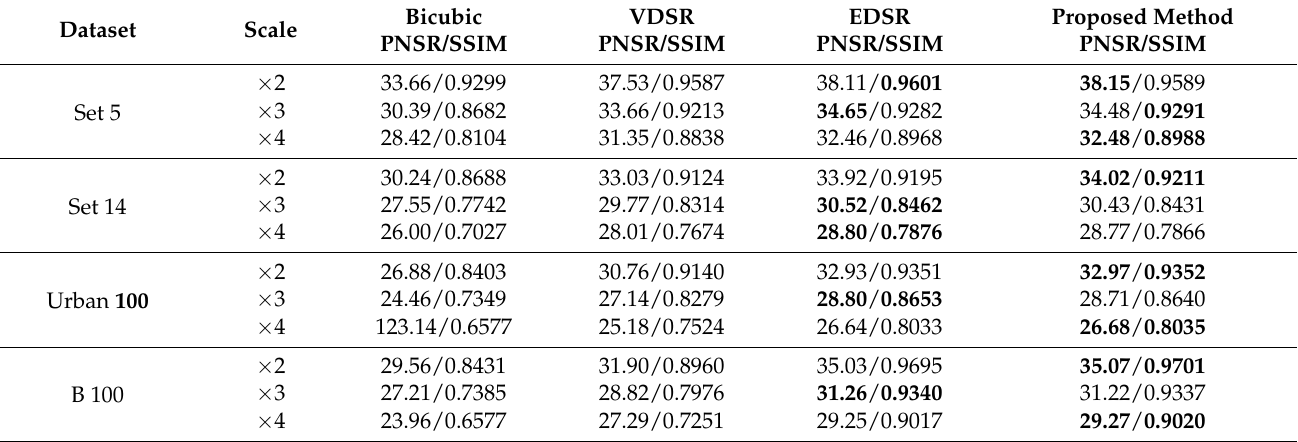
Table 1. Average PSNR/SSIM for scale factor × 2, × 3, × 4. Highlighted indicates the best